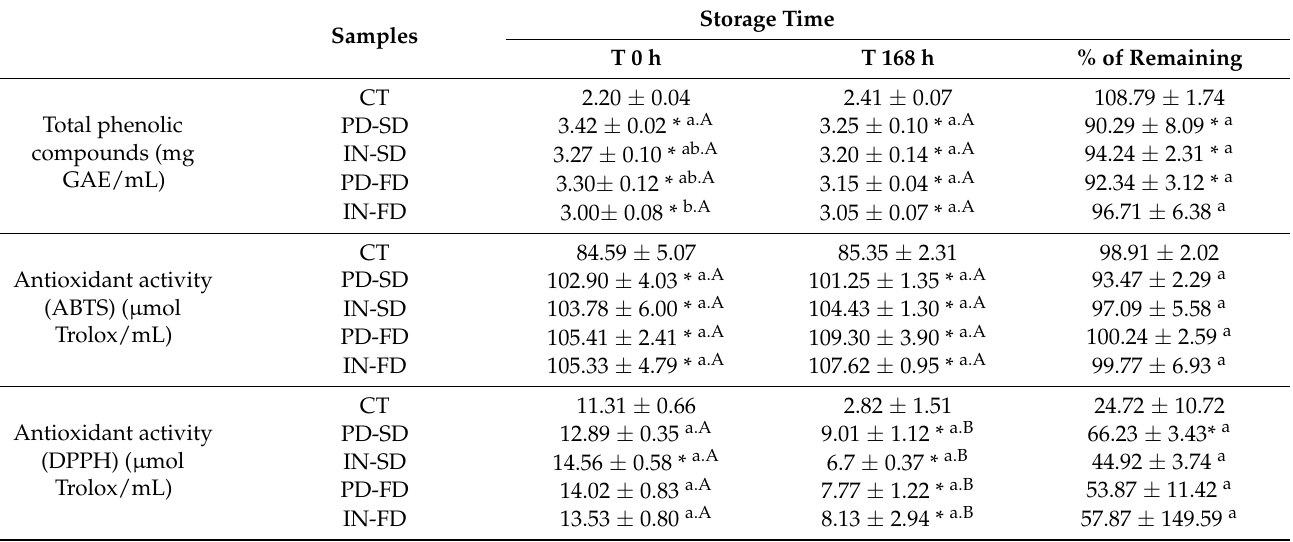
Table 2. Total phenolic content and antioxidant activity of the prepared beverages, at the beginning (T 0 h) and at the end (T 168 h) of